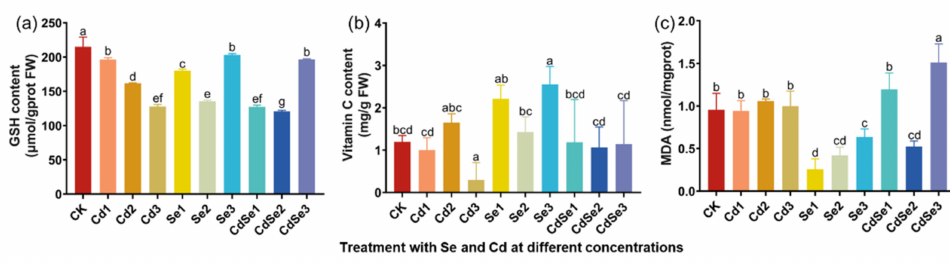
Figure 5. Changes in antioxidant content in mustard with different concentrations of Se and Cd. The error bar represents the standard deviation. The lowercase letter a to g on the bar reflects the 5% significance level. ( a ) GSH content of seedlings; ( b ) vitamin C content of seedlings; and ( c ) malondialdehyde content of